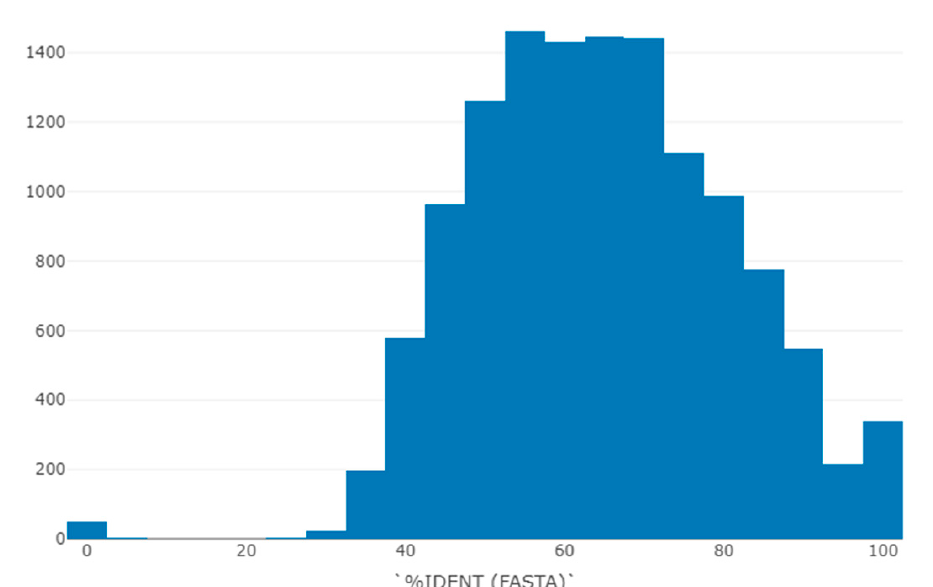
Figure 4. Histogram of the amount of amino acid sequence comprising the 3 β -corner motif in SCOP fold structures containing the 3 β -corner. The OX axis is the % of amino acid sequence, and OS is the number of structures.